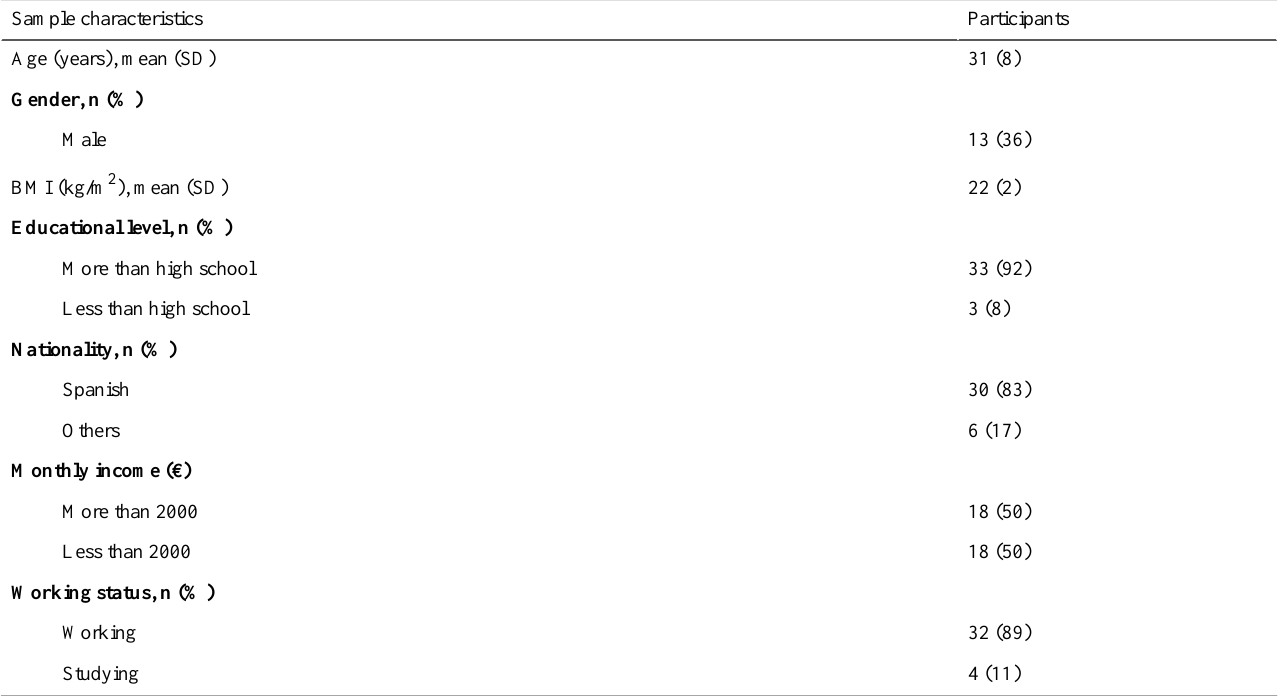
Table 2. Sociodemographic and physical characteristics of all participants (N=36). ParticipantsSample